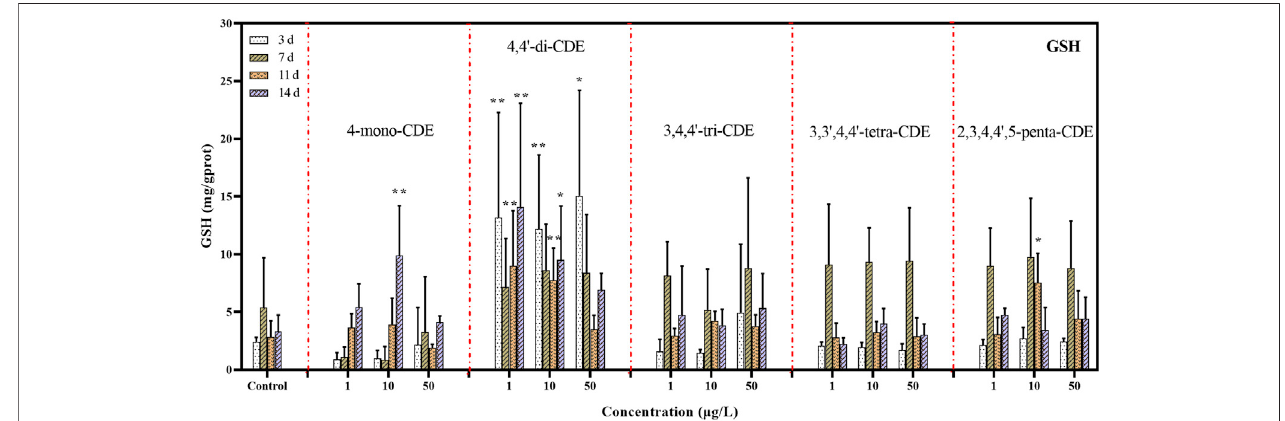
FIGURE 3 | The effect of PCDEs on the GSH levels in zebra fi sh